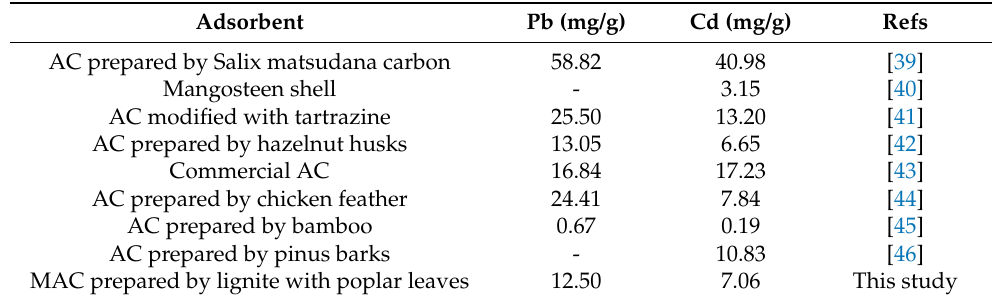
Table 6. Comparison of Cd and Pb ions removal capacity for MAC to other adsorbent materials cited in the